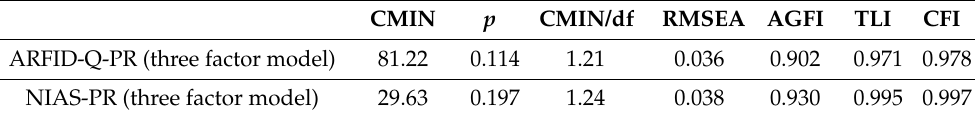
Table 9. Confirmatory analysis of CFA ARFID-Q-PR and NIAS-PR (N =